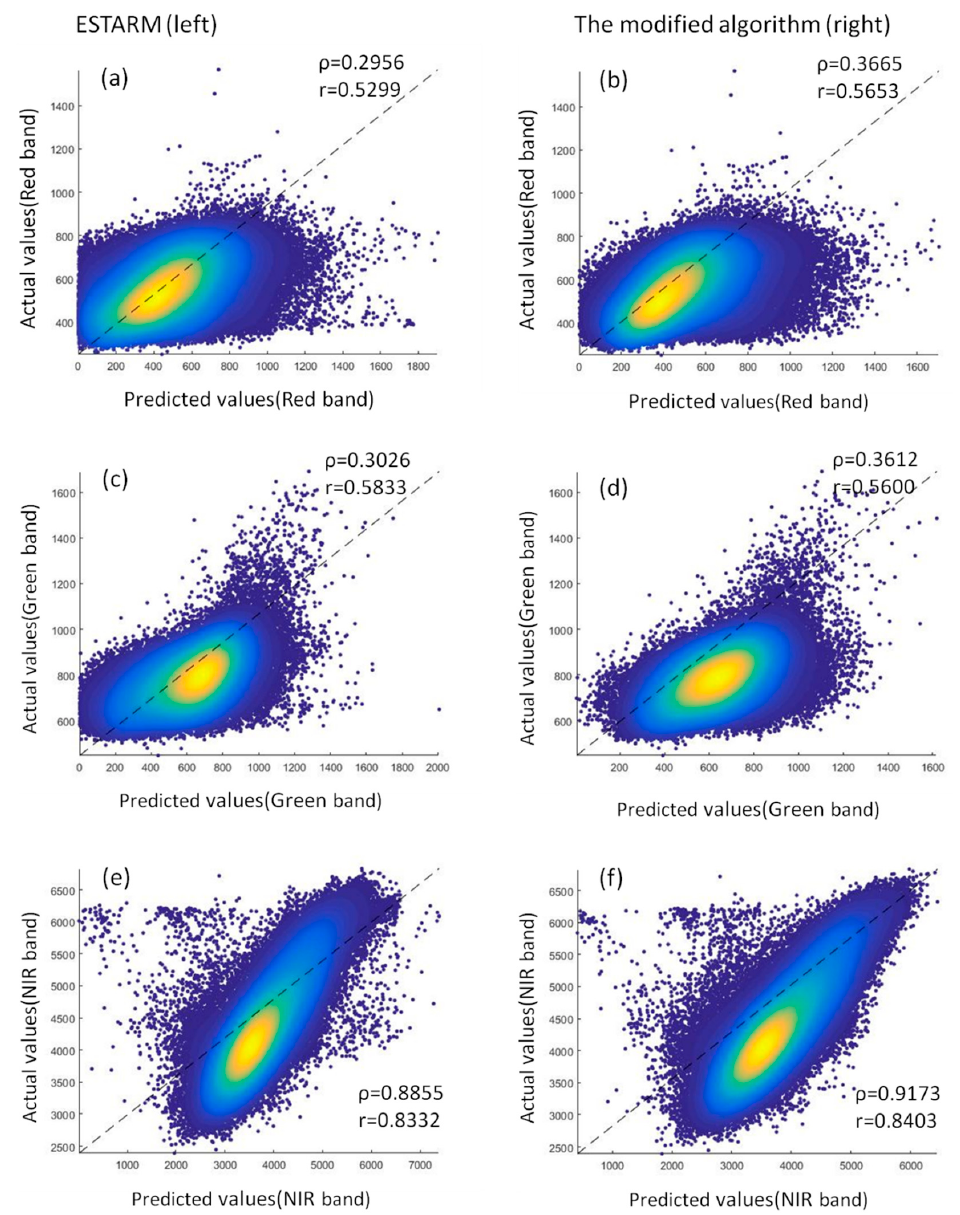
Figure 8. Scatter plots of the real reflectance and the predicted ones produced by ESTARFM ( left ) and the modified algorithm ( right ) for red ( a , b ), green ( c , d ), and NIR ( e , f ) bands.